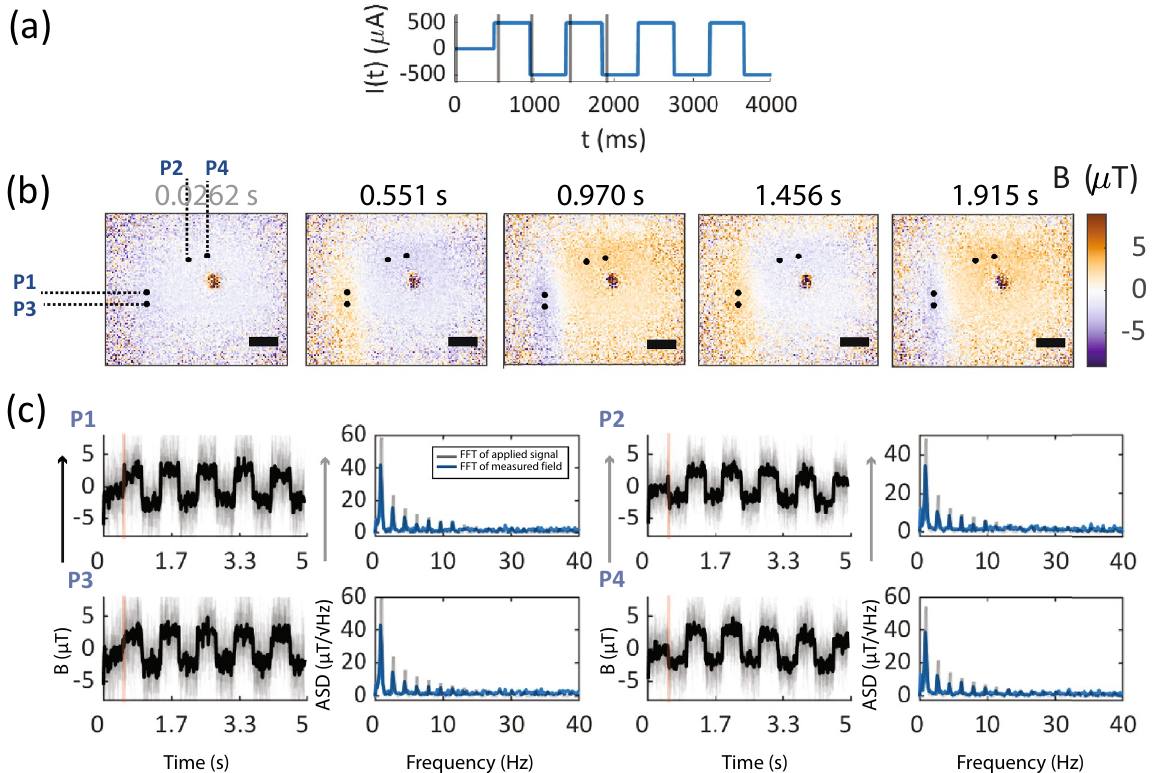
Figure 5. Temporal imaging of 1.26 Hz magnetic field variation at 78 frames per second of the 90 ◦ bend feature of the microwire sample: ( a ) Applied current waveform (blue line) to the microwire sample. Black vertical lines mark example timepoints at which single magnetic field frames have been shown. Only few initial example periodic cycles of the applied current waveform have been shown. ( b ) Magnetic field frames at single time- 15 iterations) showing alternating field image contrast with reversal in current direction. points (averaged n = No voltage applied for a baseline time of 0.5 s, first frame selected from baseline window. A periodic square wave voltage waveform of alternating polarity was applied after the baseline time, at 1.26 Hz periodicity and peak current 500 µ A . Exact magnetic field frame time-points have been shown on top of each image. Scale bar 27 µ m ( c ) Full temporal time traces of example pixels showing magnetic field tracking in time. Location of example pixels, labelled as P1 to P4 in the field of view have been shown in the magnetic field images. For each pixel, magnetic field traces versus time show tracking of applied the magnetic field, with faded gray lines as single 15 ) magnetic field traces for the given pixel. Amplitude iteration traces and solid black lines showing mean ( n = spectral density of single-pixel field traces are shown on the left, where pixel Fourier spectra are in blue and applied voltage Fourier spectra has been shown in gray. Applied voltage spectral density is scaled to a constant to compare spectral content with pixel Fourier spectra. Since pixels track magnetic field, peaks in the pixel Fourier spectra matches with peaks in the Fourier spectrum of the applied voltage, with peaks occurring at magnetic field variation 1.26 Hz and it’s odd